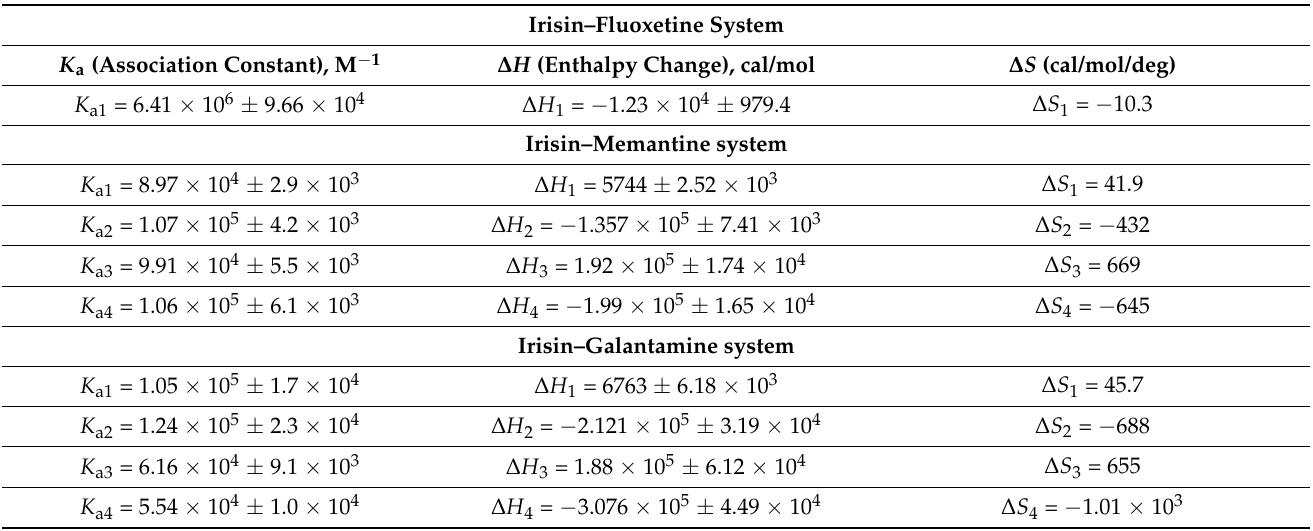
Figure 5. ITC profile of ( A ) Irisin–Fluoxetine, ( B ) Irisin–Memantine, and ( C ) Irisin–Galantamine systems. The top panels show raw data obtained upon sequentially titrating ligand into the protein of interest (irisin) present in the sample cell. The bottom panels show the binding isotherm obtained upon plotting the calorimetric titration’s integrated heat results after the correction of dilution heat against the molar ratio. Table 3. Binding and thermodynamic parameters obtained from ITC.